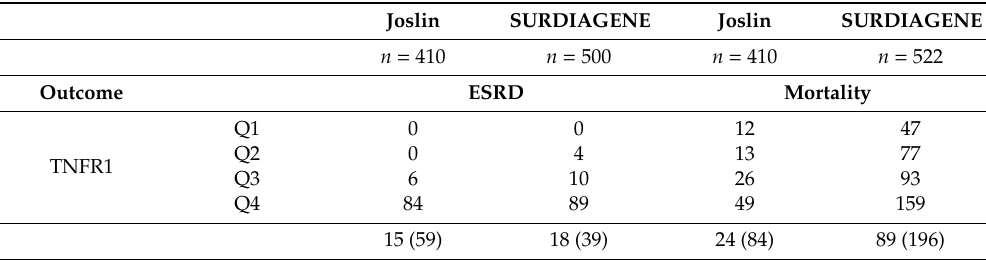
Table 2. Incidence rate of end-stage renal disease and all-cause mortality among patients with type 2 diabetes in the Joslin and SURDIAGENE study [40,51]. Joslin SURDIAGENE Joslin SURDIAGENE n = 410 n = 500 n = 410 n = 522 Outcome ESRD Mortality Q1 0 0 12 47 Q2 0 4 13 77 TNFR1 Q3 6 10 26 93 Q4 84 89 49 159 15 (59) 18 (39) 24 (84) 89